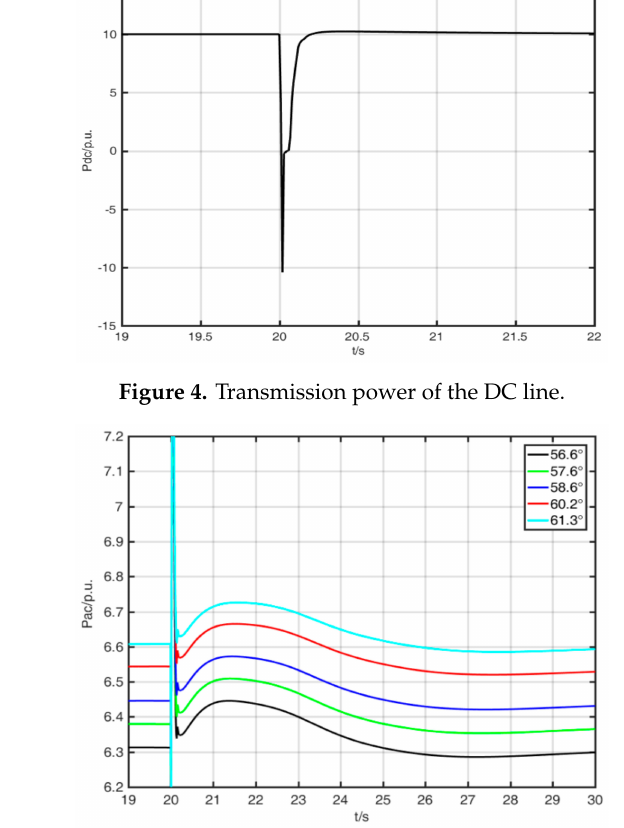
Figure 5. Power oscillation of AC tie-line at di ff erent stable operating power angles ( P DC = 10